Question: What does this figure show? Answer in one sentence.
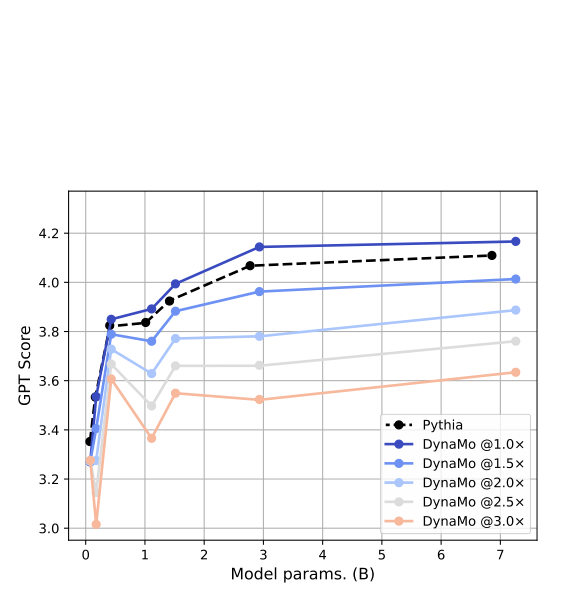
Answer: Effect of model size on GPT scores. We plot the GPT scores for DynaMo models at different speed-ups. GPT-3.5 used to judge generation quality on a scale 1-10.